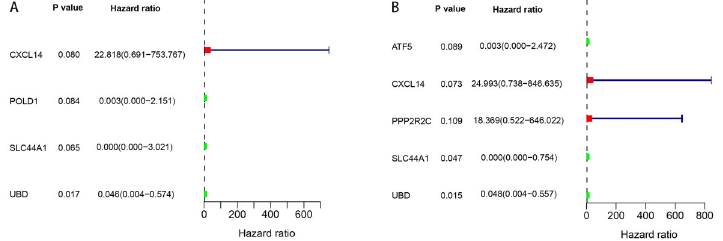
Figure 3. P values and hazard ratios of the risk of signi fi cantly differential genes (SDGs) for ( A ) disease-speci fi c survival (DSS) and ( B ) progression-free survival (PFS) models are shown. Survival analysis shows UBD is signi fi cantly associated with DSS and SLC44A1 and UBD are signi fi cantly associated with PFS in the univariate Cox regression. Table 2. Signi fi cantly differential genes (SDGs) associated with prognosis in multivariate cox regression.